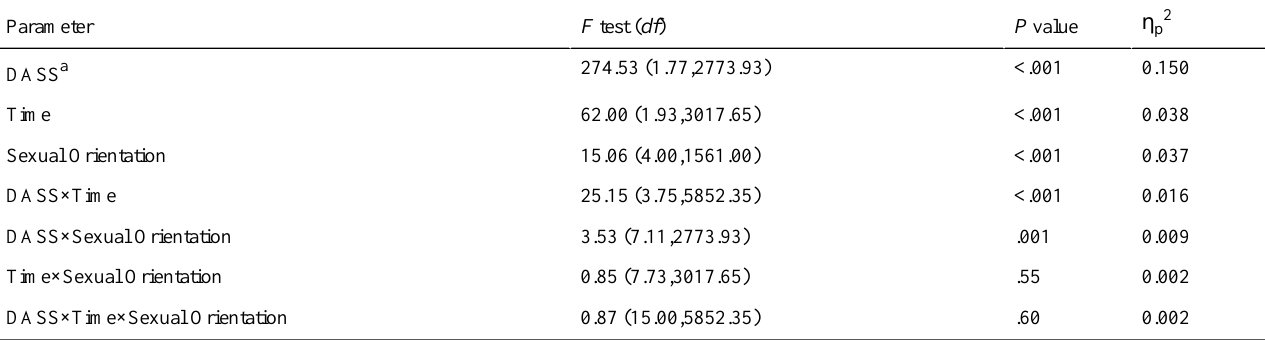
Table 4. Repeated measures effects of DASS across time, by sexual orientation.